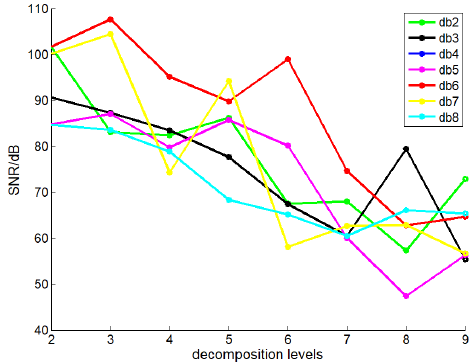
Figure 6. Results de-noised by different kinds of wavelet bases.